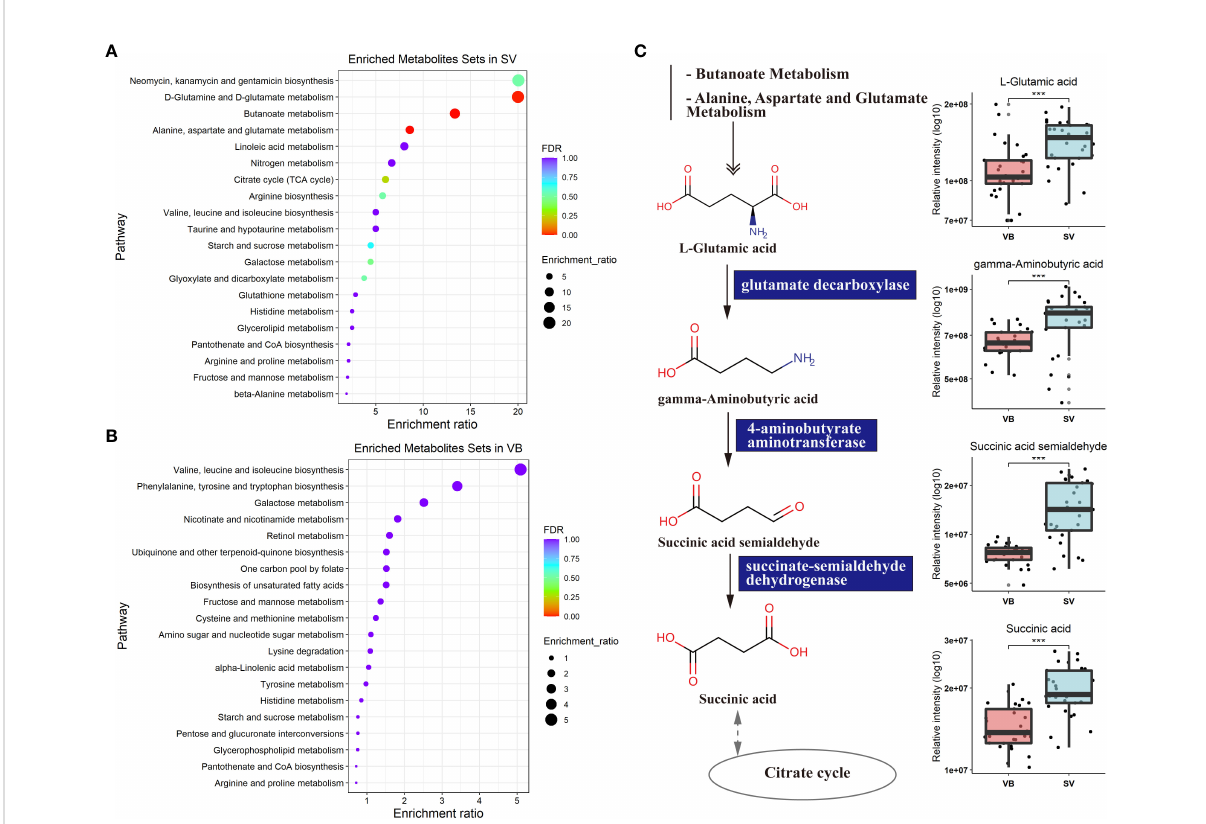
FIGURE 4 Metabolic KEGG enrichment analysis based on the differential metabolites between groups. (A) KEGG pathway analysis of differentiating metabolites enriched in the SV group. The color of the bubbles represents the value of adjusted p value, and the size of bubbles represents the number of counts (sorted by enrichment ratio). (B) KEGG pathway analysis of distinguishing metabolites increase unique to the VB group. (C) Schematic diagram of four SV-enriched metabolites participating in the butanoate metabolism and the alanine, aspartate, and glutamate metabolism KEGG pathways. Triple asterisks indicate p <